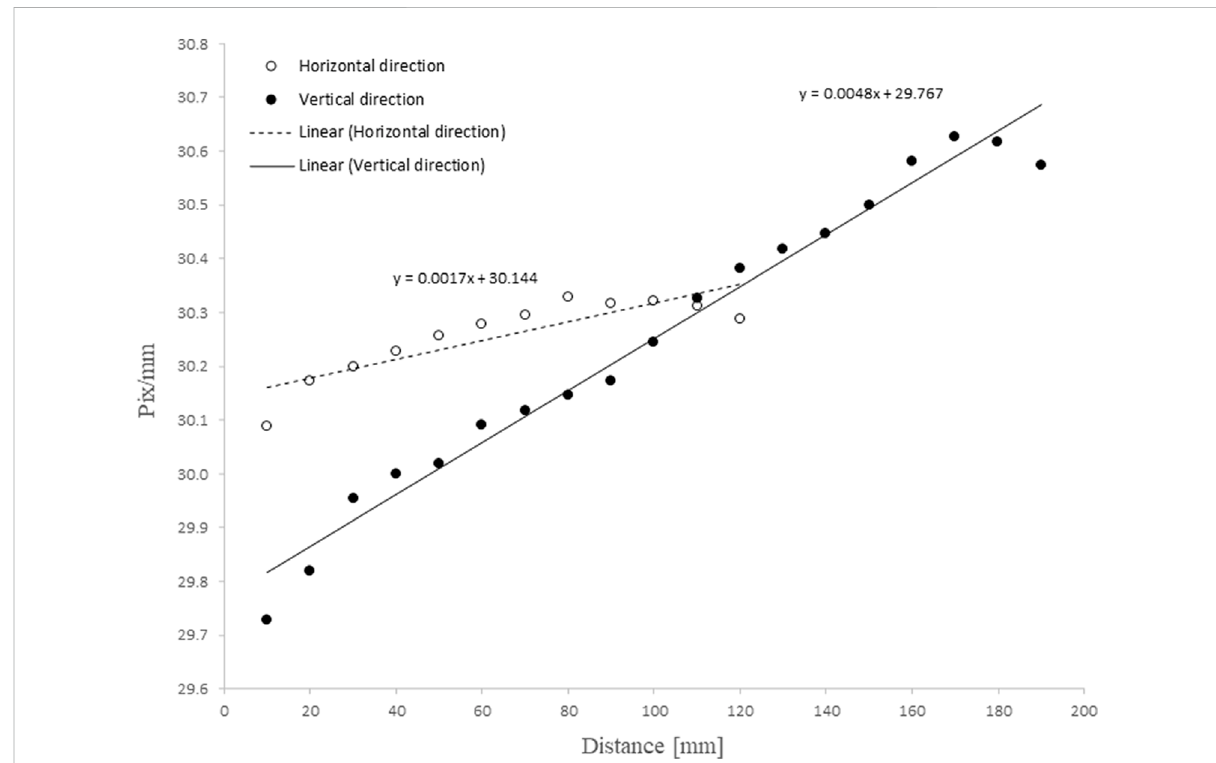
FIGURE 9 Physically straight lines in a graph paper were measured across the horizontal and vertical directions to quantify the magnitude of the optical distortions caused by the camera lens. The lines in the vertical direction, coincident with the main permeability direction (K 1 ), showed an increasing pixels length when measured along thehorizontal axisof thegraph paper.These differences do not allow to use aconstant conversionfactor (pixel/ mm) to the entirety of the